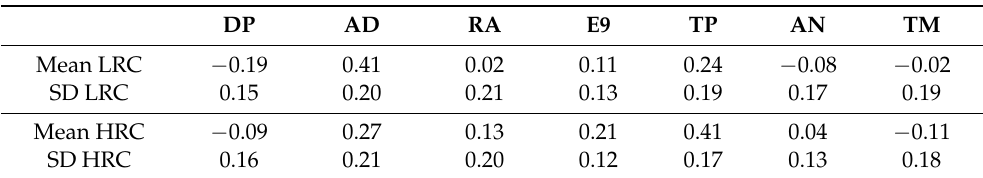
Table A5. Parameters of the normal distributions of the values of the selected markers in the used dataset, per class. SD means standard deviation. For formatting, markers are identified with the labels from Table 2. DP